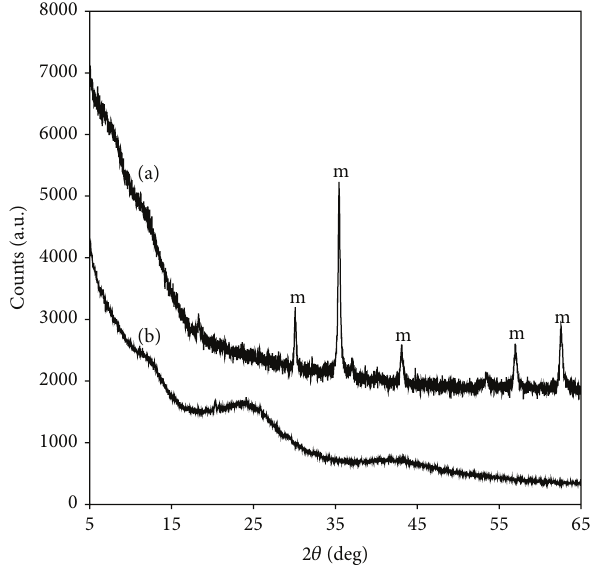
Figure 1: Diffractogram of (a) magnetic modified carbon support and (b) activated